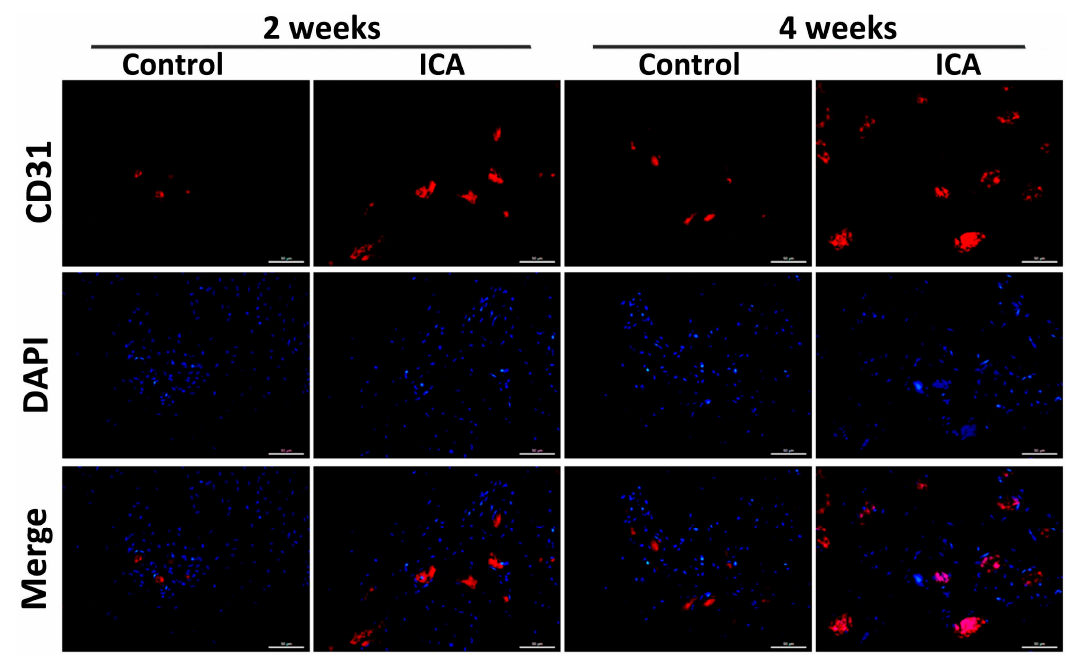
Figure 5. Results of the immunofluorescence staining of CD31. The results of immunofluorescence staining of the samples showed that the CD31 protein expression was significantly increased after ICA treatment, bar = 50 μ m.